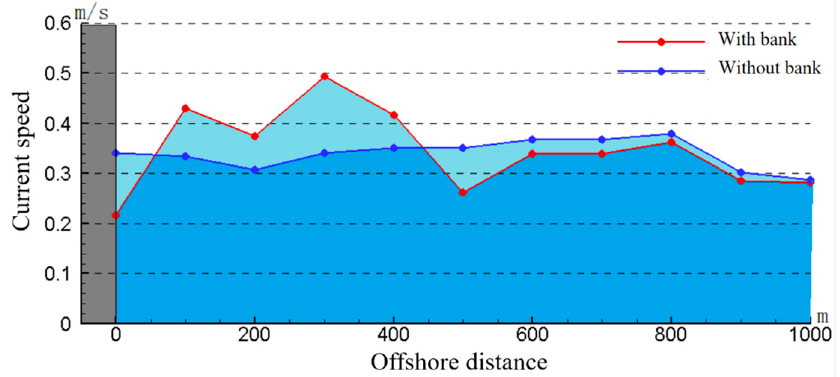
Figure 12. Comparison of velocity in sea area outside embankment.